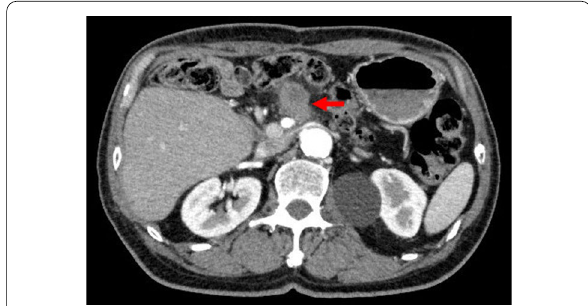
Fig. 7 Recurrence at the superior mesenteric plexus. At 30 months after the first operation, contrast-enhanced computed tomography findings showed an abdominal mass at the superior mesenteric plexus